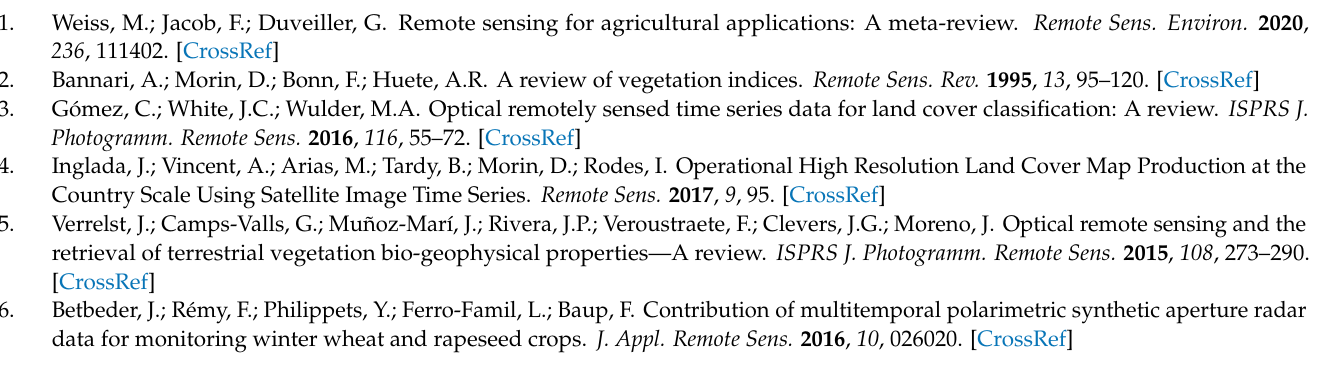
equal to 20%. Figure S11: Precision vs. outlier ratio for a complete growing season analysis of the rapeseed parcels. Various sets of features using the IF algorithm are compared. Figure S12: 100 × (Number of detected parcels in each category/Number of detected parcels). Various sets of features are compared with the IF algorithm and an outlier ratio equal to 20% for a complete growing season analysis (rapeseed crops). Figure S13: 100 × (Number of detected parcels in each category/Number of detected parcels). Various outlier ratio are tested with the same set of features and the IF algorithm for a complete growing season analysis (rapeseed crops). Figure S14: Precision vs. outlier ratio for a complete growing season analysis of the rapeseed parcels. Various statistics of the NDVI are compared using the IF algorithm. Figure S15: Precision vs. outlier ratio for a complete growing season analysis of the rapeseed parcels. Various sets of S1 features are compared using the IF algorithm. Figure S16: Precision vs. outlier ratio for a complete season analysis of the rapeseed dataset. Missing dates means that only 1 S2 image out of 2 was taken (6 S2 images instead of 13). Figure S17: Precision vs. outlier ratio for complete season analysis of the rapeseed dataset. Missing dates means that only the S2 images acquired after April were used (7 images). Figure S18: Precision vs. outlier ratio for a mid-season analysis of rapeseed parcels (all images available before February). Various sets of features are compared using the IF algorithm. Figure S19: 100 × (Number of detected parcels in each category/Number of detected parcels). Results obtained for a mid-season analysis (before February) and a complete growing season analysis are compared for a outlier ratio equal to 10% in the rapeseed dataset. Figure S20: Example of parcel boundaries (rapeseed crop, growing season 2017/2018). In orange:customer database, in green: LPIS database. Figure S21: 100 × (Number of detected parcels in each category/Number of detected parcels). LPIS and proprietary parcellation databases are compared with the IF algorithm and an outlier ratio equal to